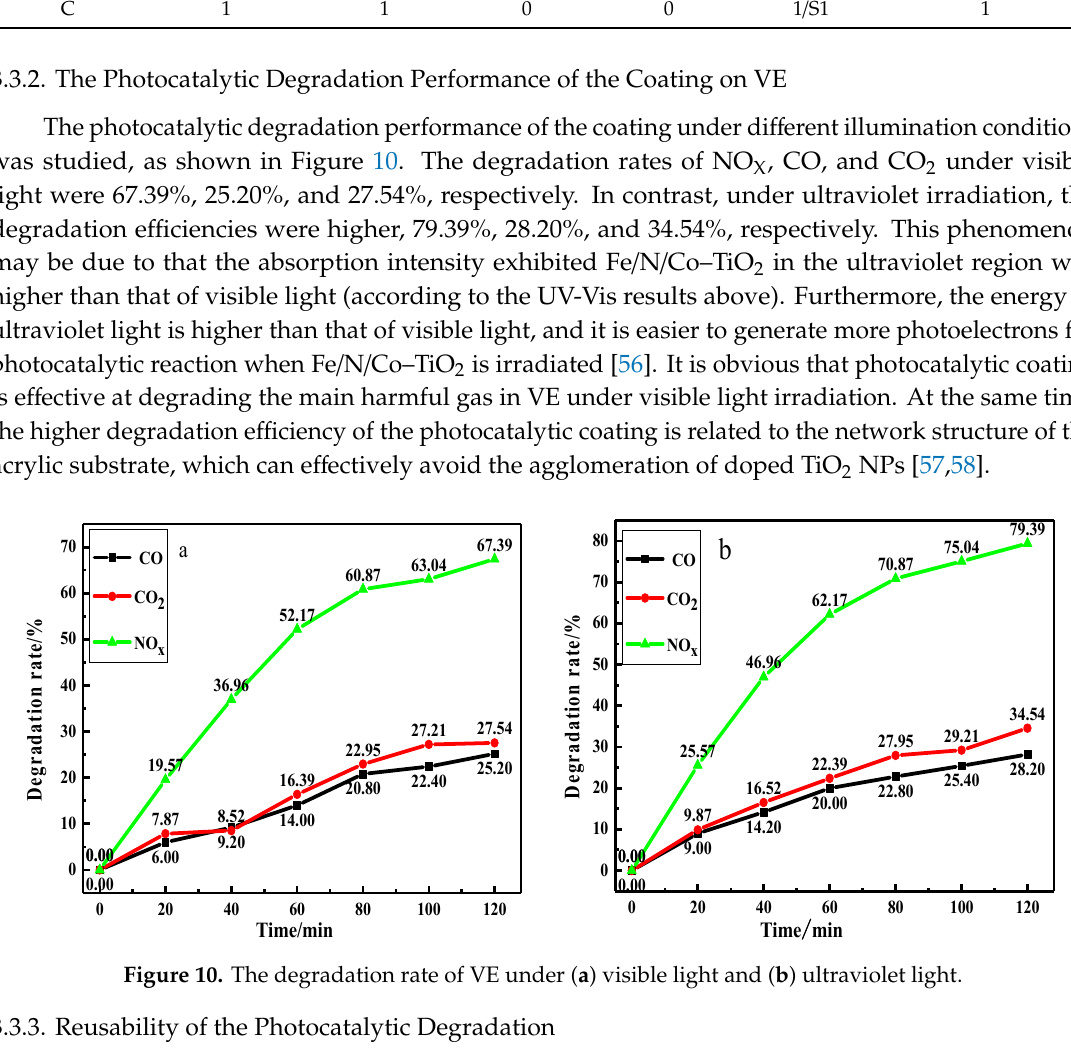
NO X CO CO 2 Figure 11. The reusability for VE degradation performance of photocatalytic coating. 3.3.4. Durability of the Photocatalytic Coating